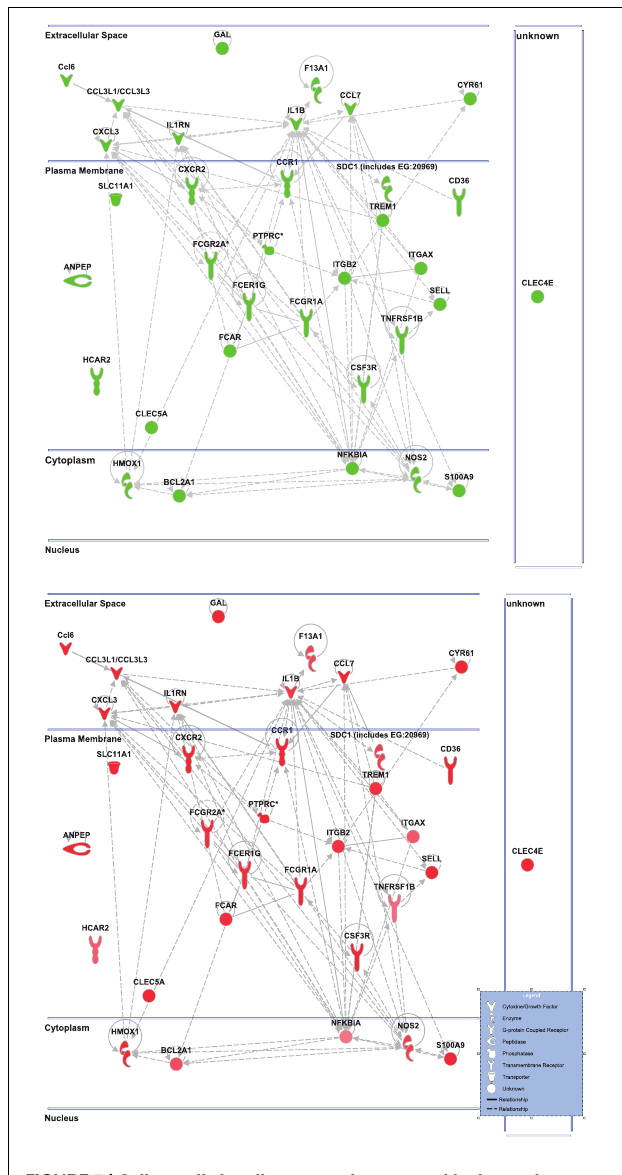
FIGURE 5 | Cell-to-cell signaling network generated by ingenuity pathway analysis of differentially expressed genes: Molecules are represented as nodes, and the biological relationship between two nodes is represented as an edge (line). All edges are supported by at least one reference from the literature, from a textbook, or from canonical information stored in the Ingenuity Knowledge Base.The intensity of the node color indicates the degree of up- (red) or down- (green) regulation. Nodes are displayed using various shapes that represent the functional class of the gene product. Edges are displayed with various labels that describe the nature of the relationship between the nodes.Top: the nicotinamide treated injured animals compared to vehicle treated injured animal. Bottom: the vehicle treated injured animals compared to sham controls highlighting only the genes affected by nicotinamide treatment shown in the top